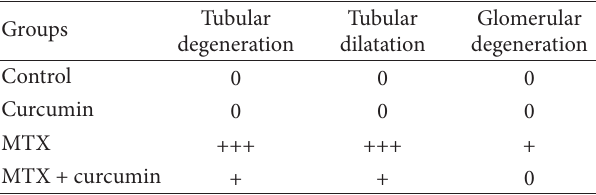
Table 1: Effect of curcumin on the severity of histopathological lesions in methotrexate- (MTX-) induced nephrotoxicity in rats. Tubular Tubular Glomerular Groups degeneration dilatation degeneration Control 0 0 0